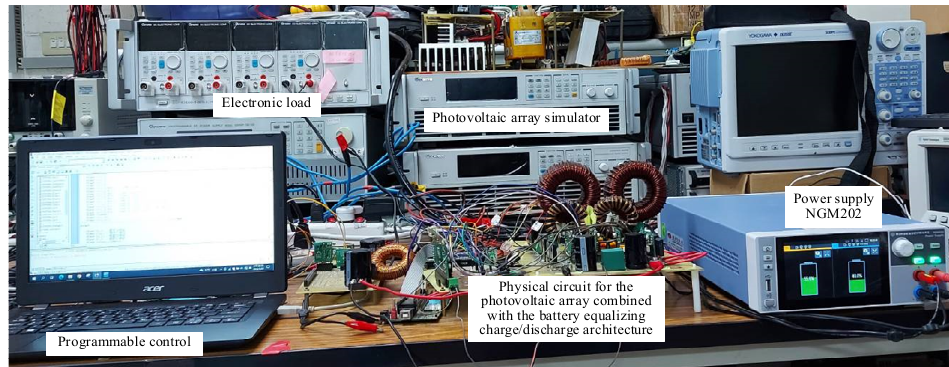
Figure 13. Experiment operating environment for the PVMA combined with the battery equalizing charge/discharge control.